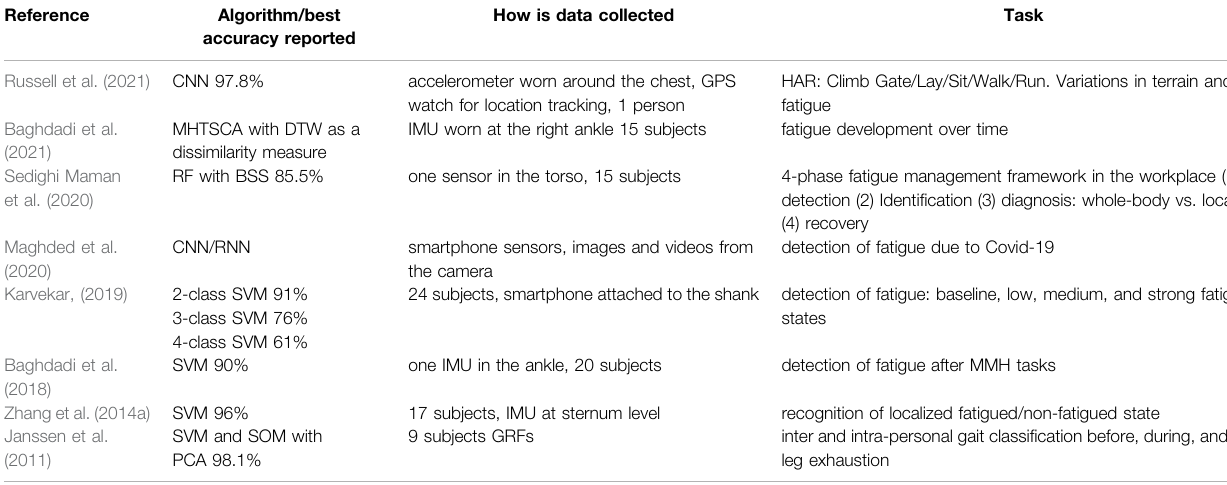
TABLE 3 | Summary of fatigued gait